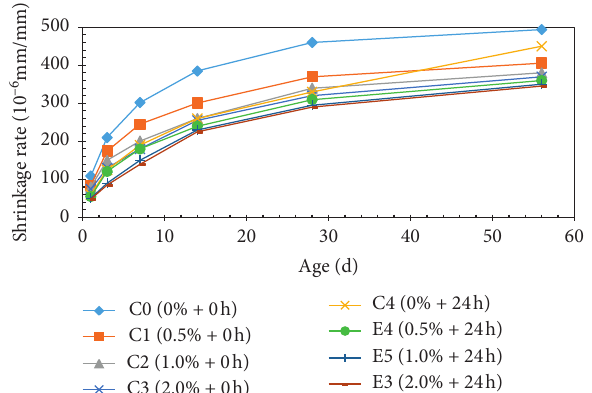
Figure 14: Effect of SRA dose on the shrinkage of the concrete for different prewetting times.